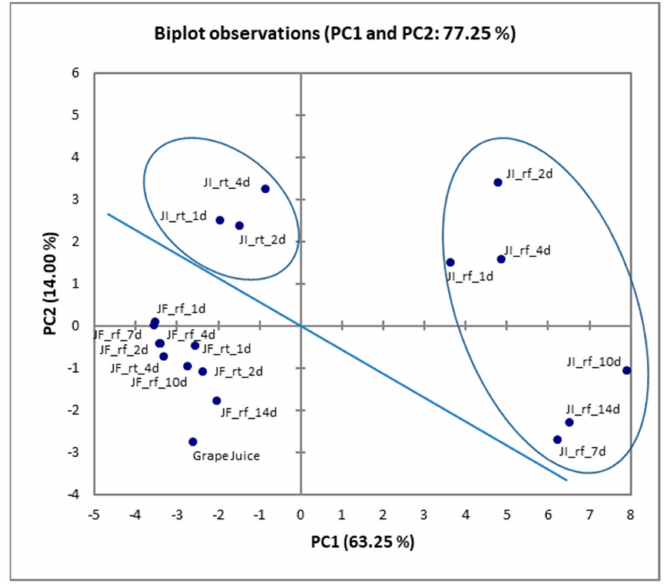
Figure 3. Principal component analysis (PCA) plot of minor volatiles isolated by novel juice products fortified with freeze-dried L. rhamnosus OLXAL-1 cells. JF: juice fortified with free cells, JI: juice fortified with immobilized cells on apple pieces. The storage temperature is indicated as rt (room temperature) or rf (refrigeration), while the storage days are shown at the end of the sample